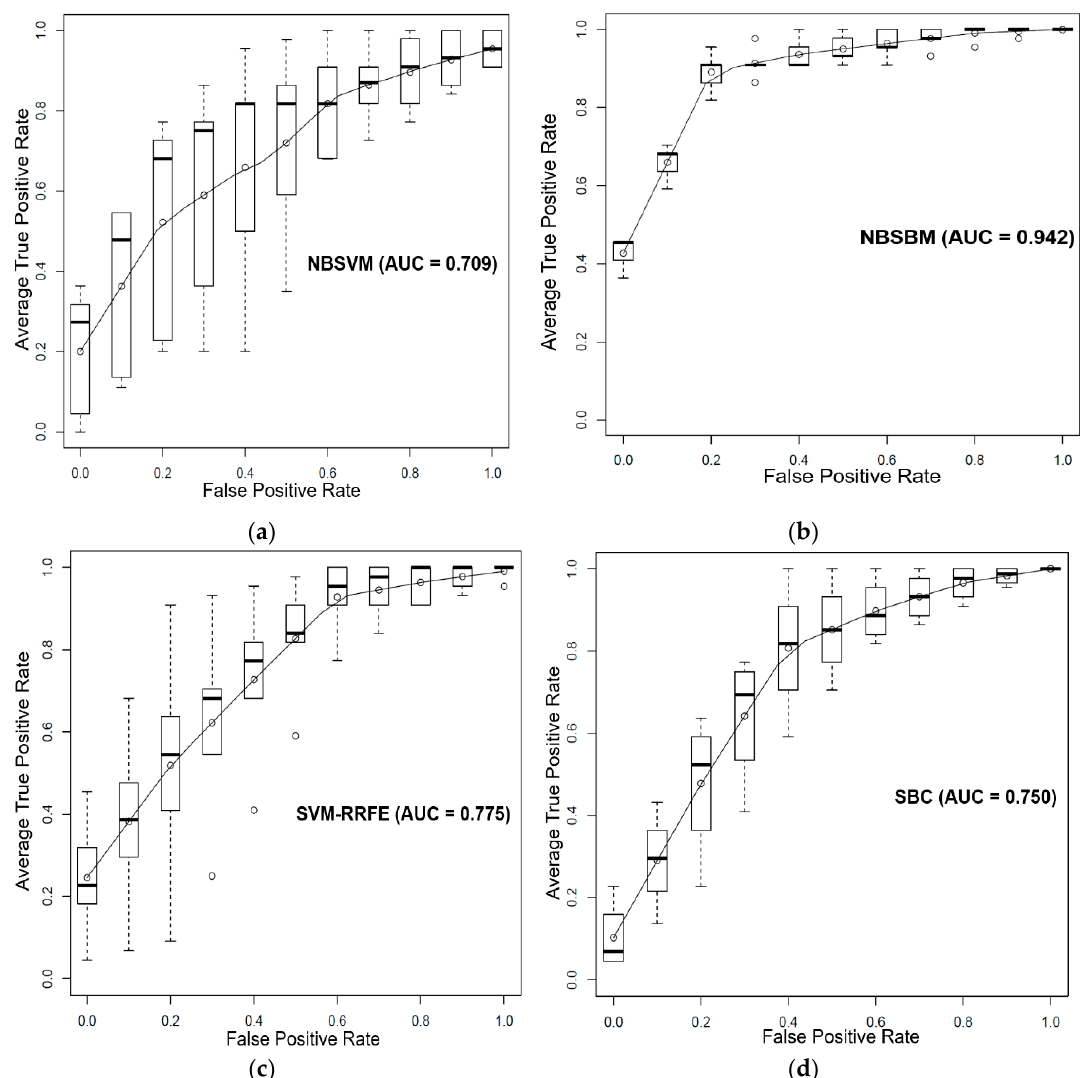
Figure 1. Comparison performance of the network-based sparse Bayesian machine (NBSBM) with other methods in terms of average (mean) operating characteristic (ROC) (5-fold cross-validation and 5-repeats), and AUC value. The boxplot indicates the variation around the average ROC curve and reports the median and the interquartile range. ROC curves of ( a ) network-based SVM, ( b ) the proposed approach, ( c ) SVM-RRFE, and ( d ) sparse Bayesian classifier (SBC) to classify the response of 16 prostate cancer cell lines to Dasatinib.